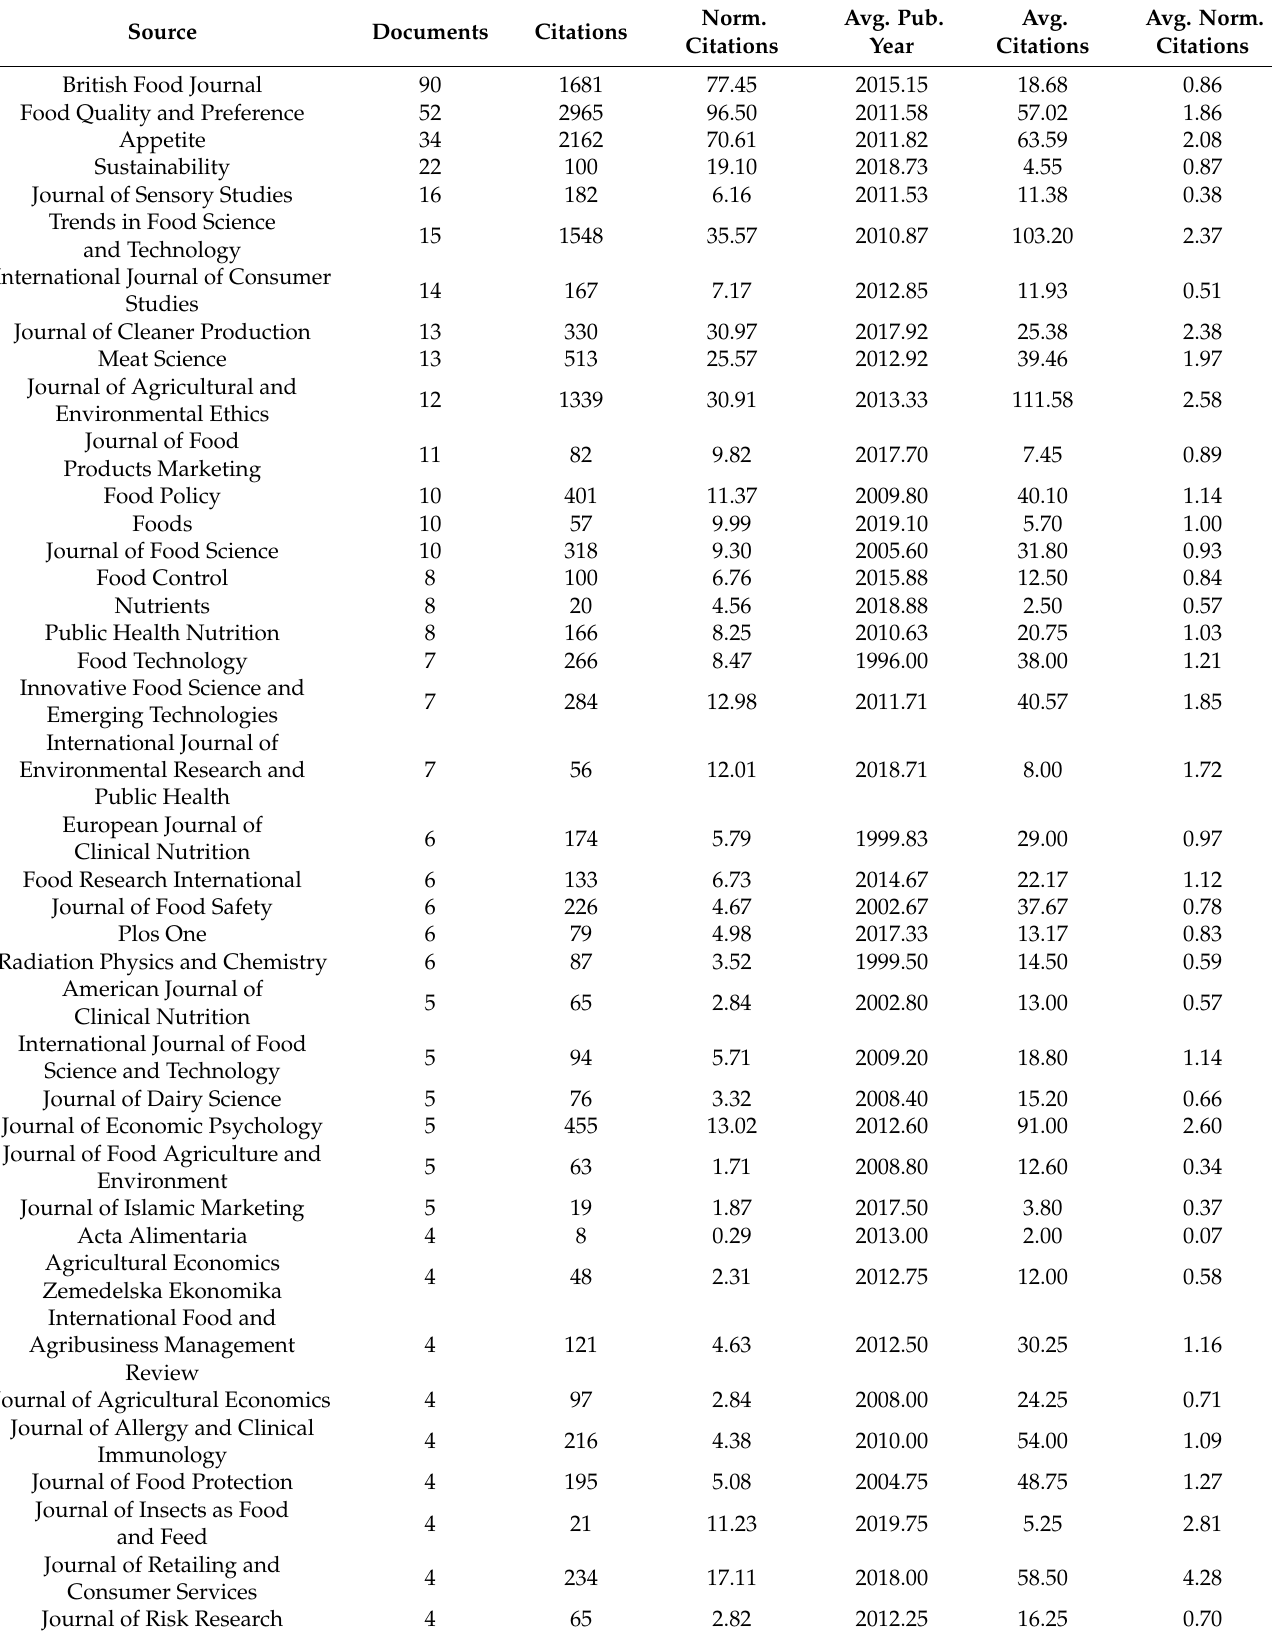
Table A2. Bibliometric information for the sources with more documents (top